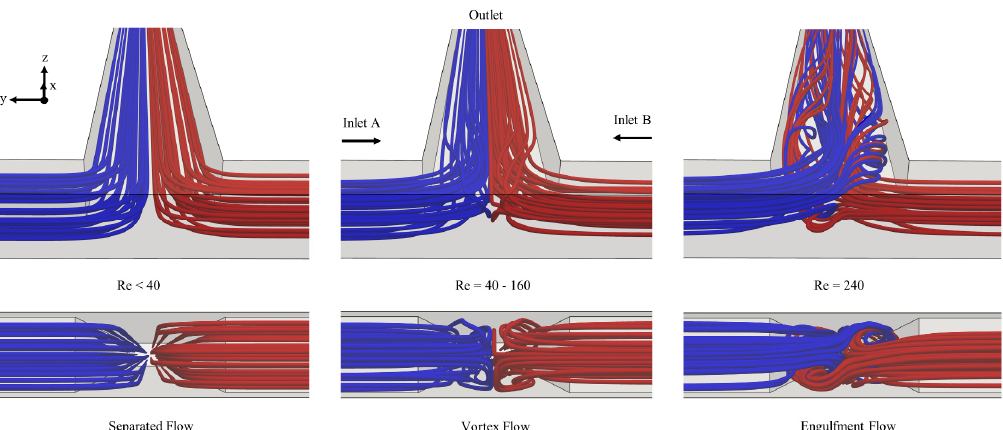
Figure 4. Flow regimes in the CT micromixer: separated, vortex, and engulfment. Blue and red colors are used to differentiate flow pathlines in inlets A and B.